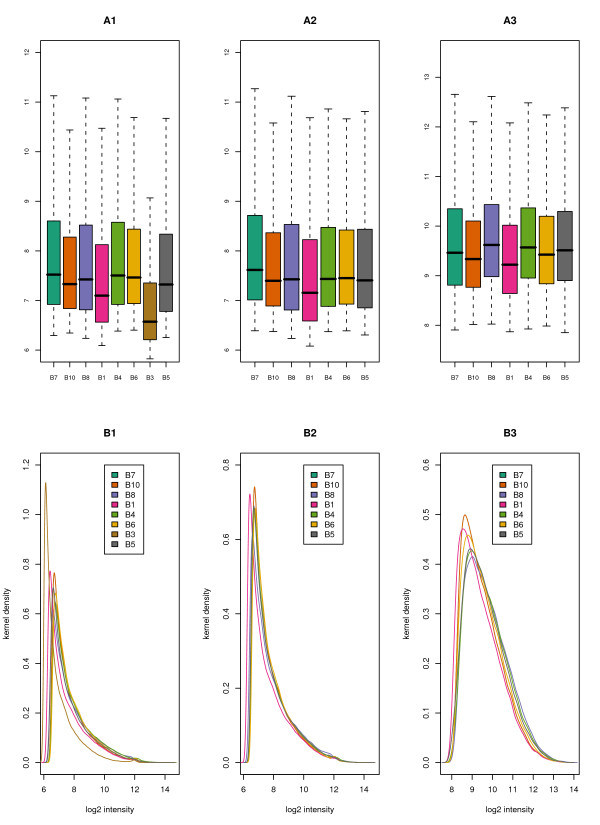
Batch Summary of Cleansing Process. Batch characteristics resulting from the affy package analysis. Boxplots (top row) and densities (bottom row) of the Bhattacharjee data: summary of batch intensities. The color of batch results is consistent in all graphs, as indicated in the key in the B panels. The y-axes are the log2 of the intensities of the probes in a batch. Panels A1 and B1 depict the completely unfiltered data set, including all probes and Batch 3: note the obvious offset in Batch 3 and the strong skew to the resulting distributions. Panels A2 and B2 show the effects of removing Batch 3 and additional outlying samples, but include all probes: the skew remains significant but no batches are outliers. Panels A3 and B3 show the output after both sample cleansing and BaFL probe filtering: the distribution is more normal but the tails have been truncated. Note that the total density scale in panel B3 is reduced relative to B1 and B2 because fewer probes are included and less variance is observed. Similar output for the Stearman experiment is provided as Additional file 3[19].